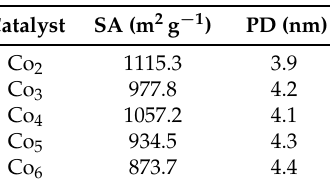
Figure 2. ( A ) NLDFT pore size distribution of each MCM-41–Co catalyst. ( B ) Co 6 NLDFT pore size distribution deconvolution using Gaussian functions. Table 1. Nitrogen adsorption results summary, BET surface area (SA), and pore diameter (PD) as the peak maximum in the NLDFT distribution.